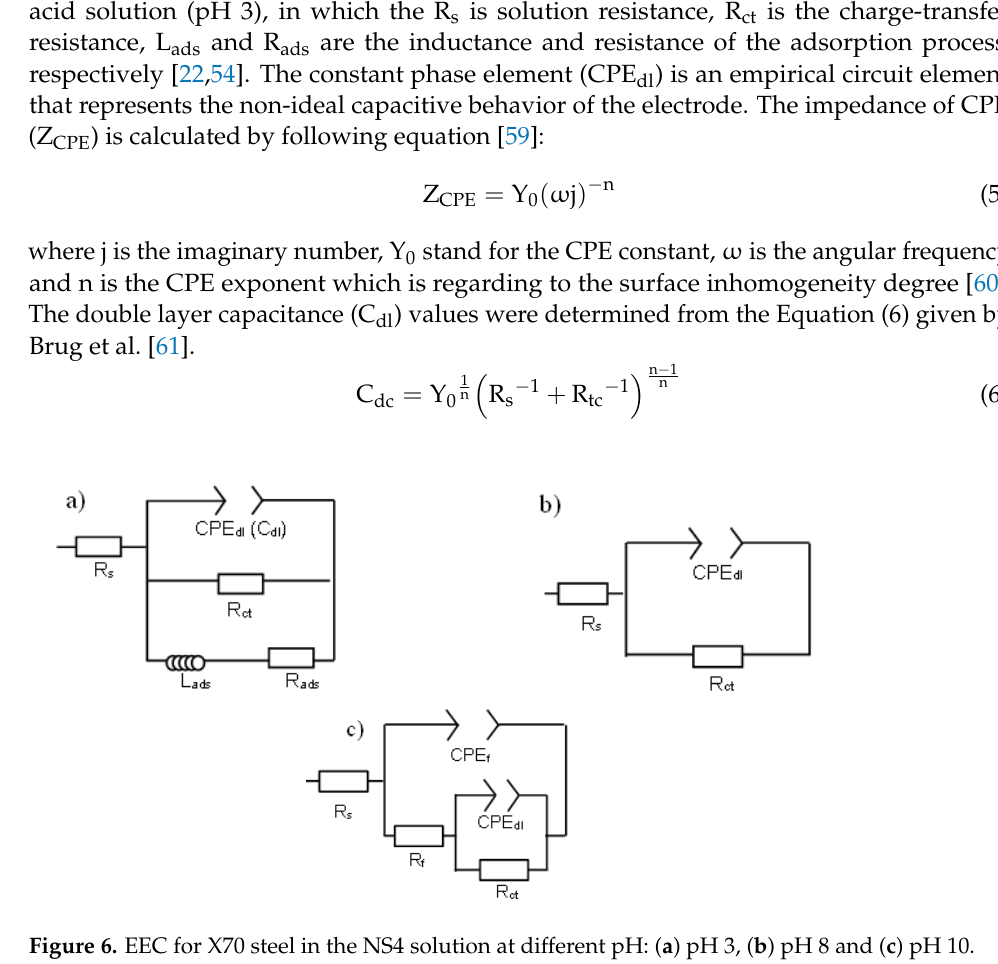
Figure 6. EEC for X70 steel in the NS4 solution at different pH: ( a ) pH 3, ( b ) pH 8 and ( c ) pH 10.